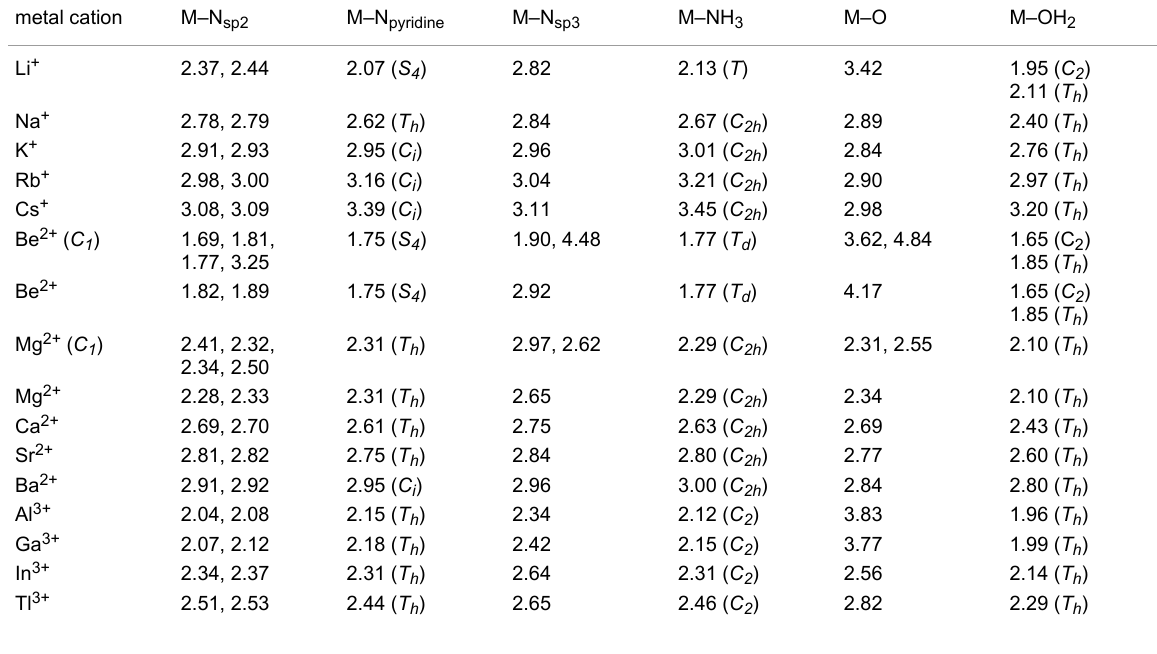
Table 8: Comparison of the calculated distances (in Å) of the metal–donor interactions in [2.bpy.bpy] with [M(pyridine) n ] m+ , [M(NH 3 ) n ] m+ and [M(H 2 O) n ] m+ (point groups are given in parenthesis, for most metal cations C 2 symmetry is